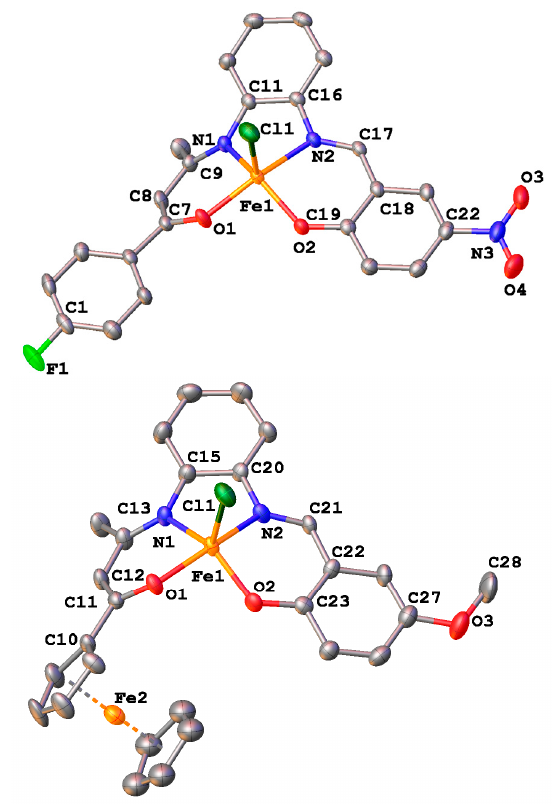
Figure 2. Molecular structures of 3 ·CH 2 Cl 2 ( top ) and 5 ·0.5CH 3 CN ( bottom ) with partial atom labelling schemes. Hydrogen atoms and crystallization solvent molecules have been omitted for clarity. Thermal ellipsoids are drawn at 50% probability. Table 1. Selected bond distances (Å) and angles ( ◦ ) for compound 2